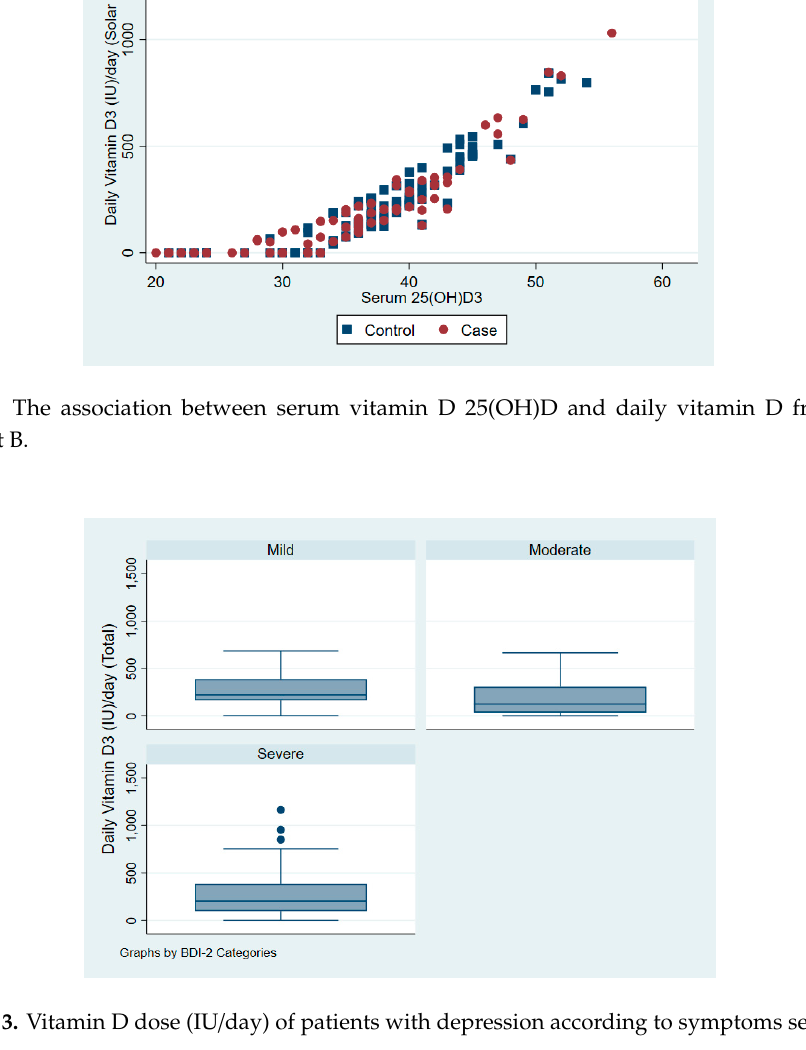
Figure 3. Vitamin D dose (IU/day) of patients with depression according to symptoms severity.